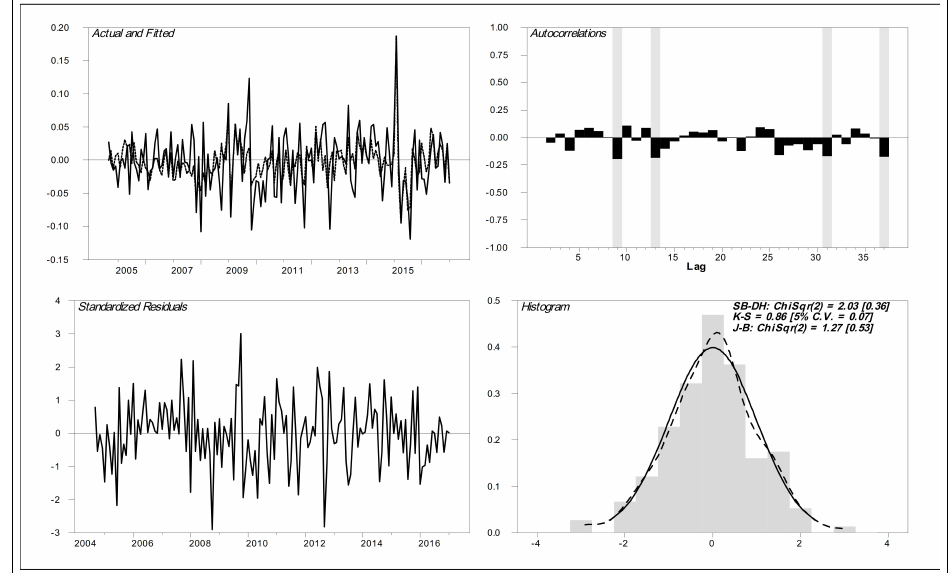
Figure 5: Graphs of actual and fitted change in confidence rate (upper left hand side panel), the standardized residuals (lower left hand side panel), the residual autocorrelogram (upper right hand side panel), and the residual histogram compared to the normal